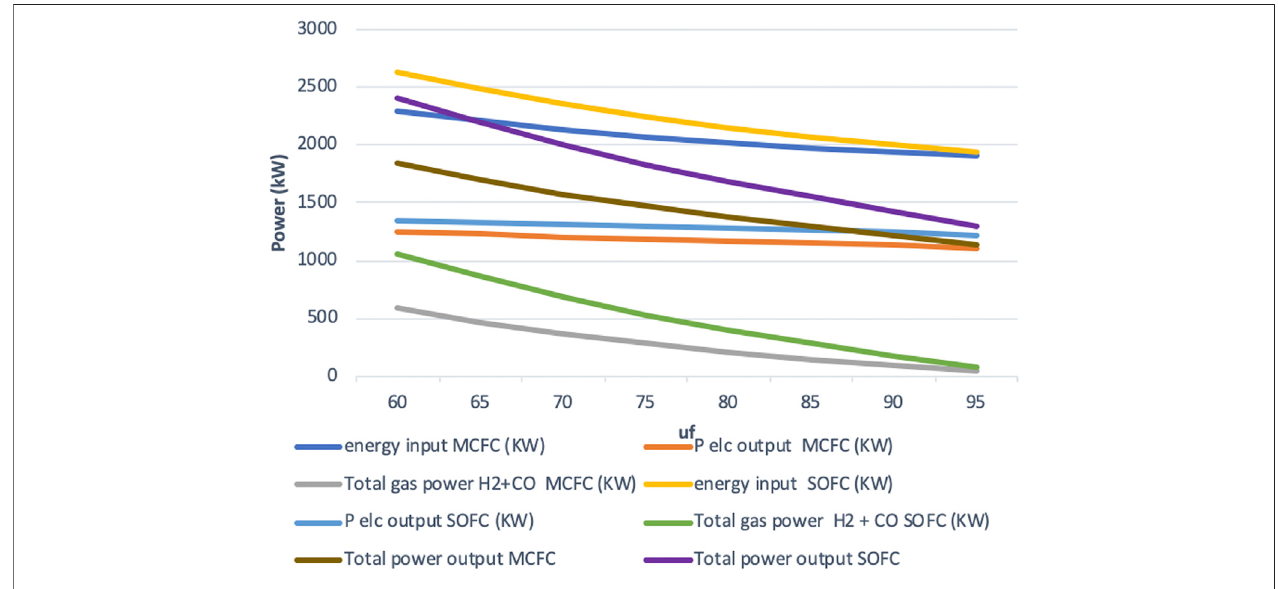
FIGURE 4 | Power output vs. fuel utilization for constant current density mode.